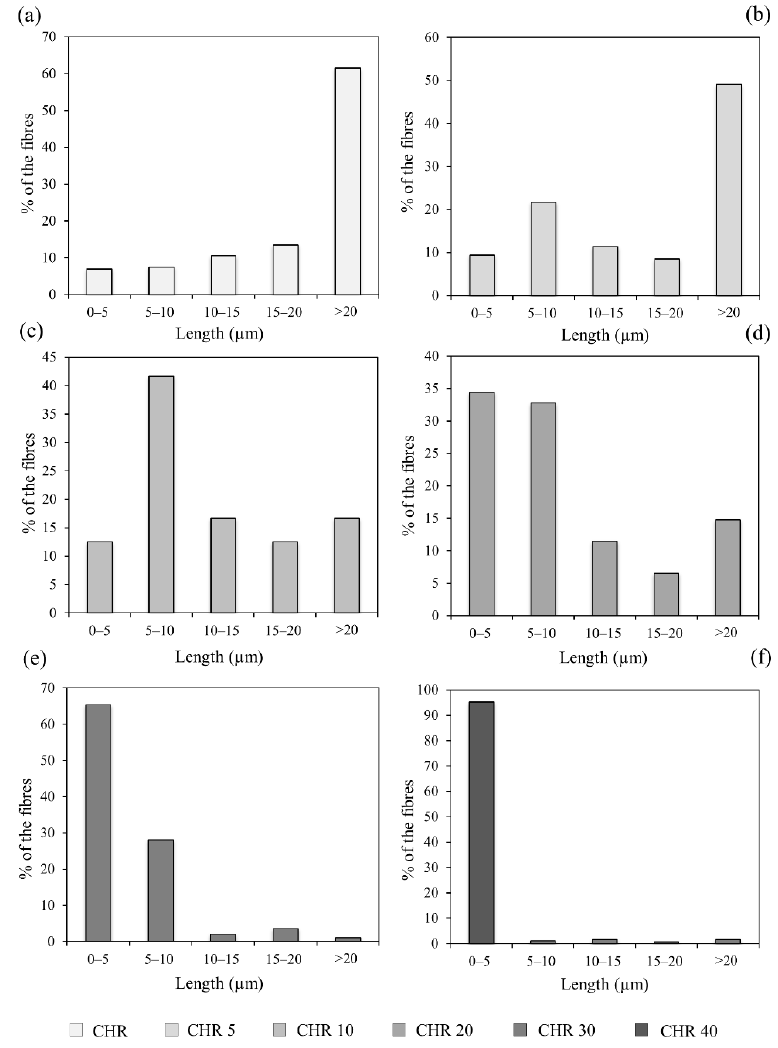
Figure 2. Chrysotile fibre length distribution (i.e., the fraction of fibres comprised in a given interval of fibre length) after each milling treatment. ( a ) Raw chrysotile (CHR). ( b ) Chrysotile after 5 min of milling (CHR5). ( c ) Chrysotile after 10 min of milling (CHR10). ( d ) Chrysotile after 20 min milling (CHR20). ( e ) Chrysotile after 30 min of milling (CHR30) ( f ) Chrysotile after 40 min of milling (CHR40). Table 3. Si and Mg content (expressed in terms of weight percent oxides) and Si/Mg ratio of raw and ground Russian chrysotile (40 min) fibres determined by 50 SEM-EDX spot analyses. Standard error of the mean in brackets.